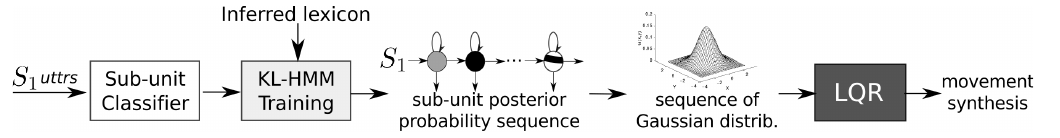
Figure 3. Illustration of the synthesis of the hand movement according to the derived